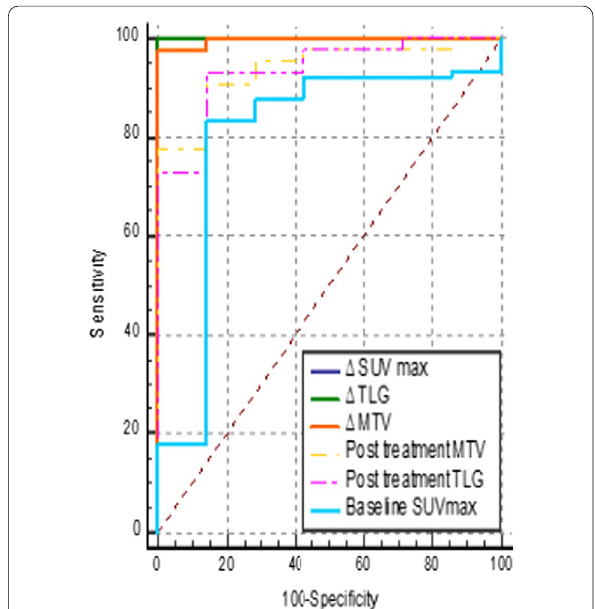
Fig. 2 ROC curve analyses of the specificity and sensitivity of using ∆ SUV, ∆ TLG, ∆ MTV, post-treatment MTV, TLG and baseline SUV in differentiating responsive and non-responsive